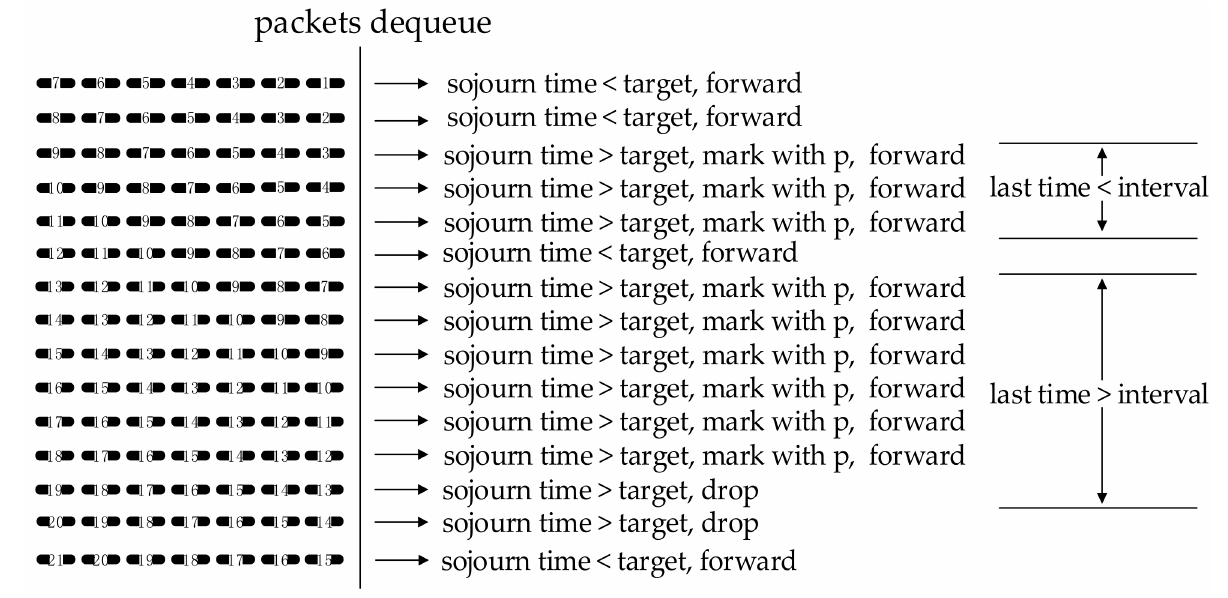
Figure 4. The dequeue packets processing logic of the improved AQM